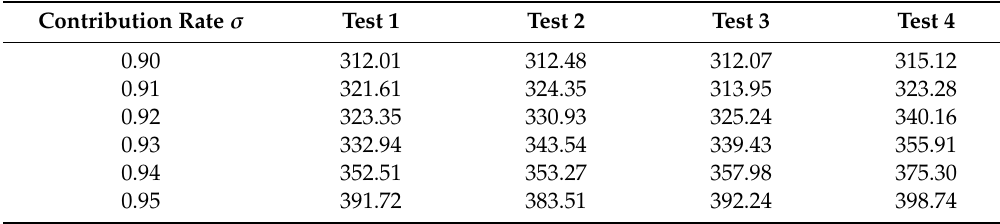
Table 5. CEA for test 1 to test 4 under di ff erent contribution